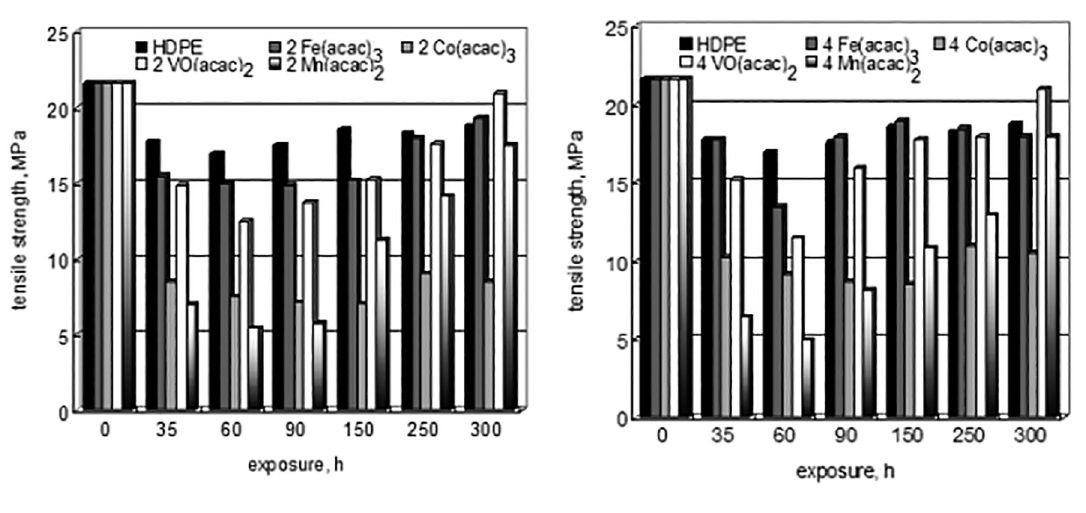
Figure 3: Dependence of the tensile strength of foils of initial irradiated HDPE and irradiated foils containing pro-oxidants at different exposure